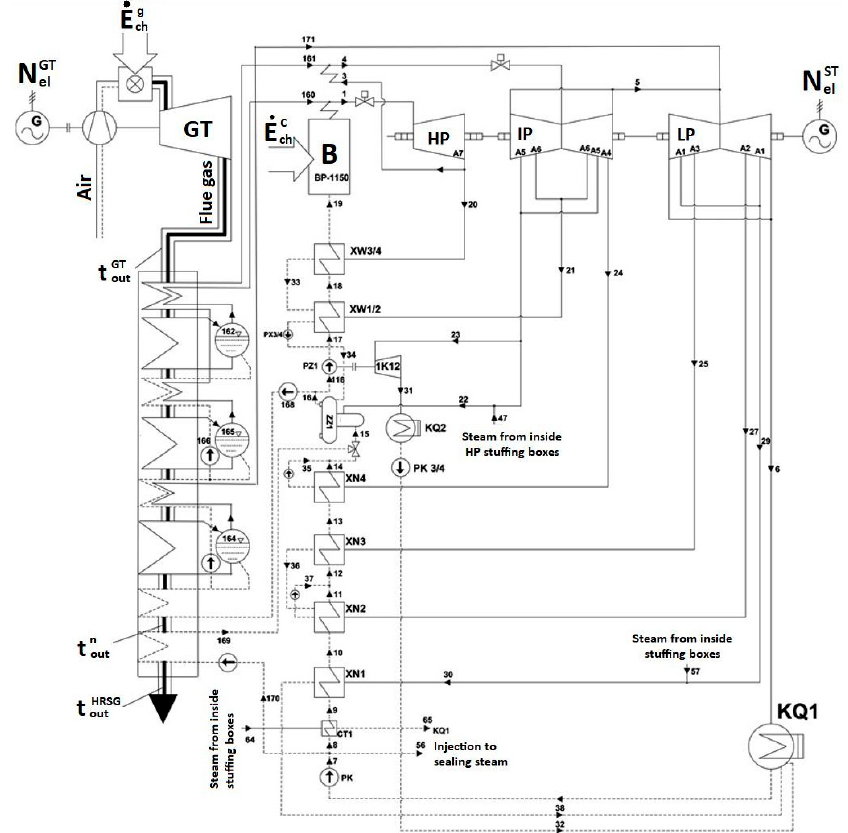
Figure 3. Heat schematic for the 370 MW power unit superstructured with a single gas turbine and a triple-pressure heat recovery steam generator (HRSG).